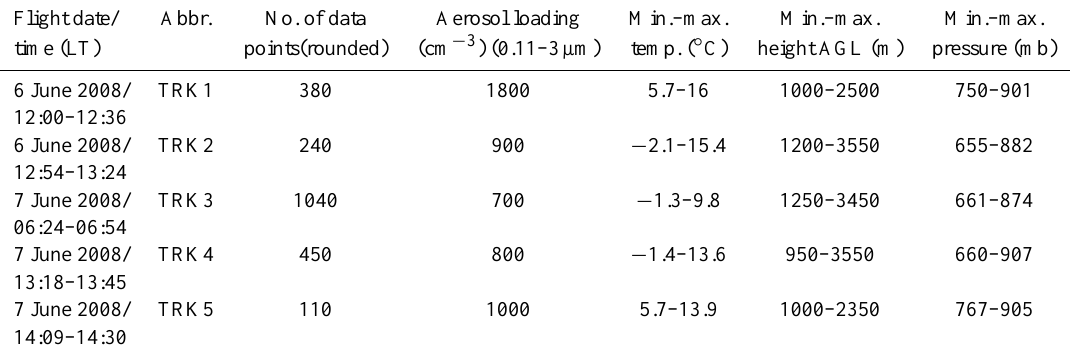
Table 1. Airborne measurements used for the present study. For each of the five airborne measurements used in the present study, the flight date and the corresponding abbreviation used in this paper, number of data points, aerosol loading at the cloud base (see Sect. 2) minimum and maximum temperature, minimum and maximum pressure, cloud base and (estimated) cloud top height are